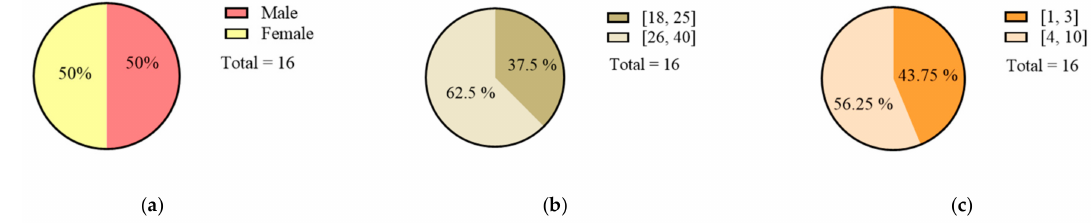
Figure 10. The descriptive statistics. ( a ) Genders. ( b ) Ages. ( c ) Driving ages. The correlation analysis shows that the correlation coefficient between the TSIQ and the male VRD is 0.472, and the correlation coefficient between the TSIQ and the female VRD is 0.616. The relationship coefficient between the TSIQ and the young VRD is 0.555, and the correlation coefficient of the old driver is 0.588. The correlation coefficient between the TSIQ and the VRD of the novice driver is 0.551, and the correlation coefficient with the experienced driver is 0.557. It can consider that the above relationships are significant when the confidence level is 0.05. That is, when the driver recognizes the traffic sign, the more information transmits, the longer the driver’s VRD. The correlation analysis table is shown in Table 6. Table 6. The correlation analysis table.